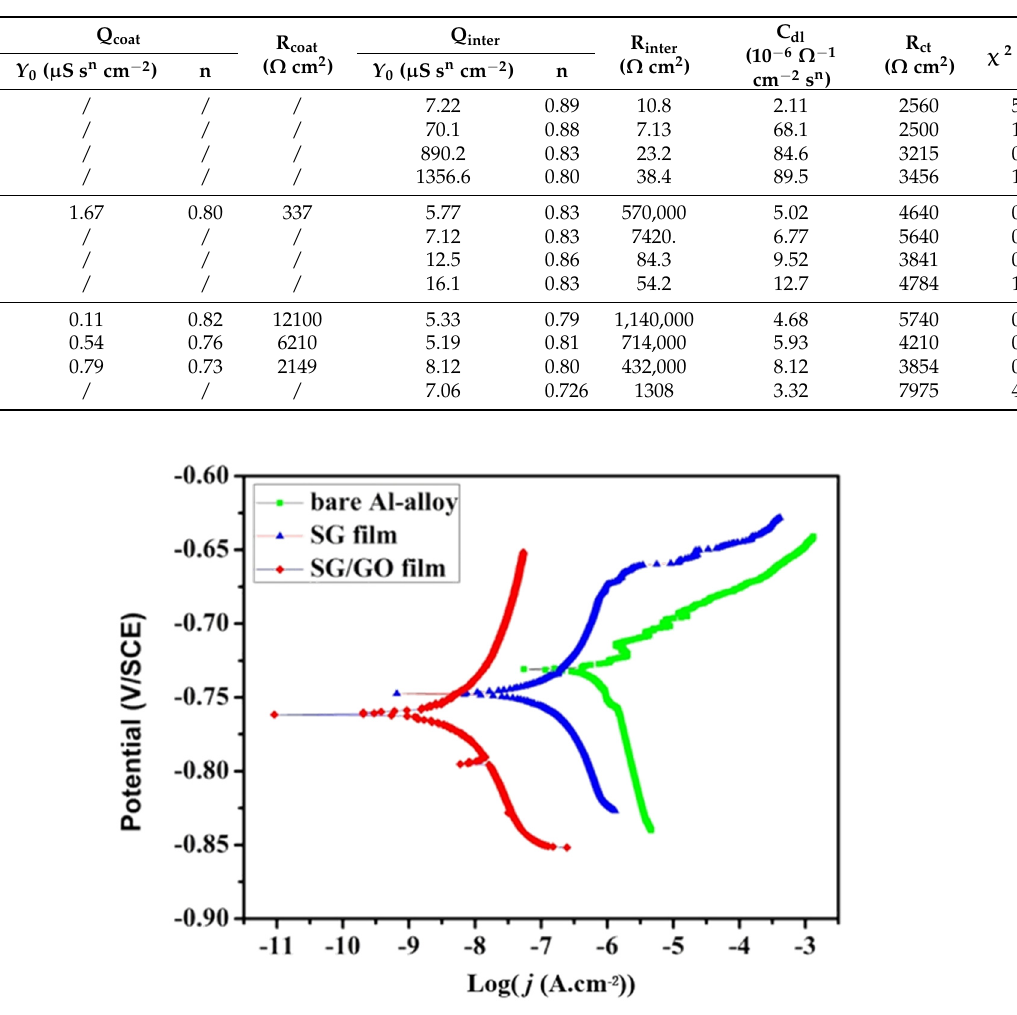
Figure 3. Potentiodynamic polarization curves of bare alloy sample and samples coated with SG film and SG/GO film after 1 h immersion in 3.5 wt.% NaCl solution.